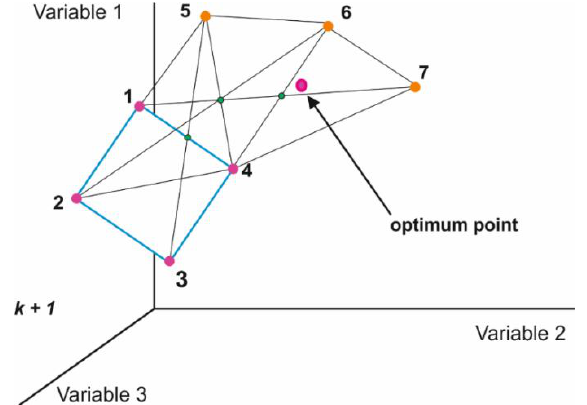
Figure 6. Example of the displacement of initial simplex to the region of optimum response of three variables.